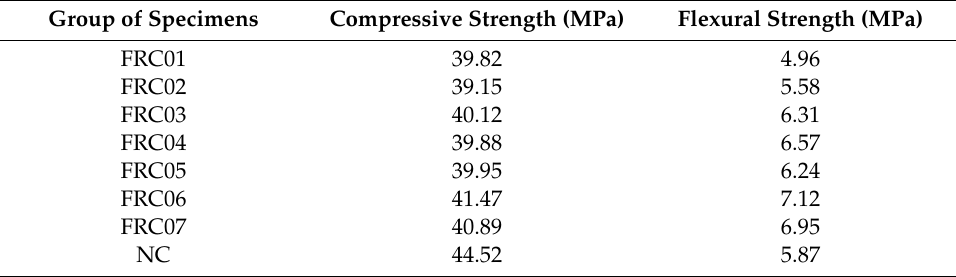
Table 6. Compressive strength and flexural strength of concrete